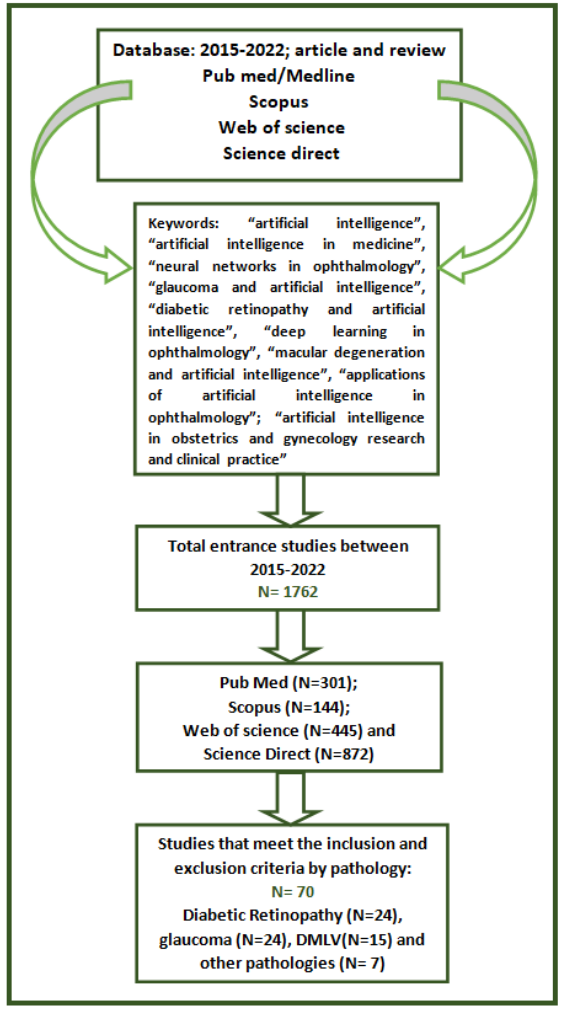
Figure 2. A flowchart of the current survey design, strategy, results, and studies that complied with the eligibility criteria .